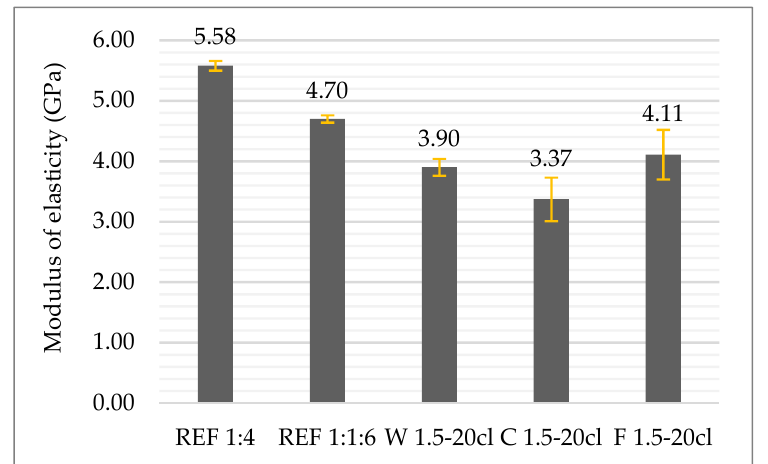
Figure 10. Modulus of elasticity of the mortars at 28 days.